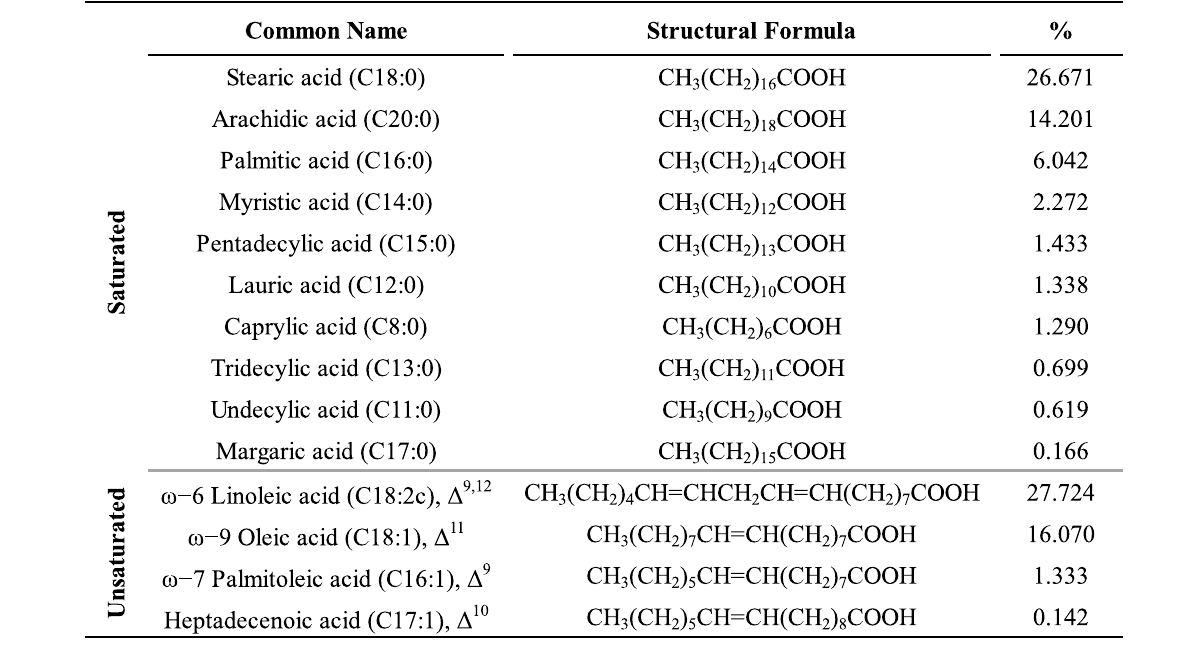
Table 4 Fatty acid composition (% of total fatty acids) of Chlorella sp.